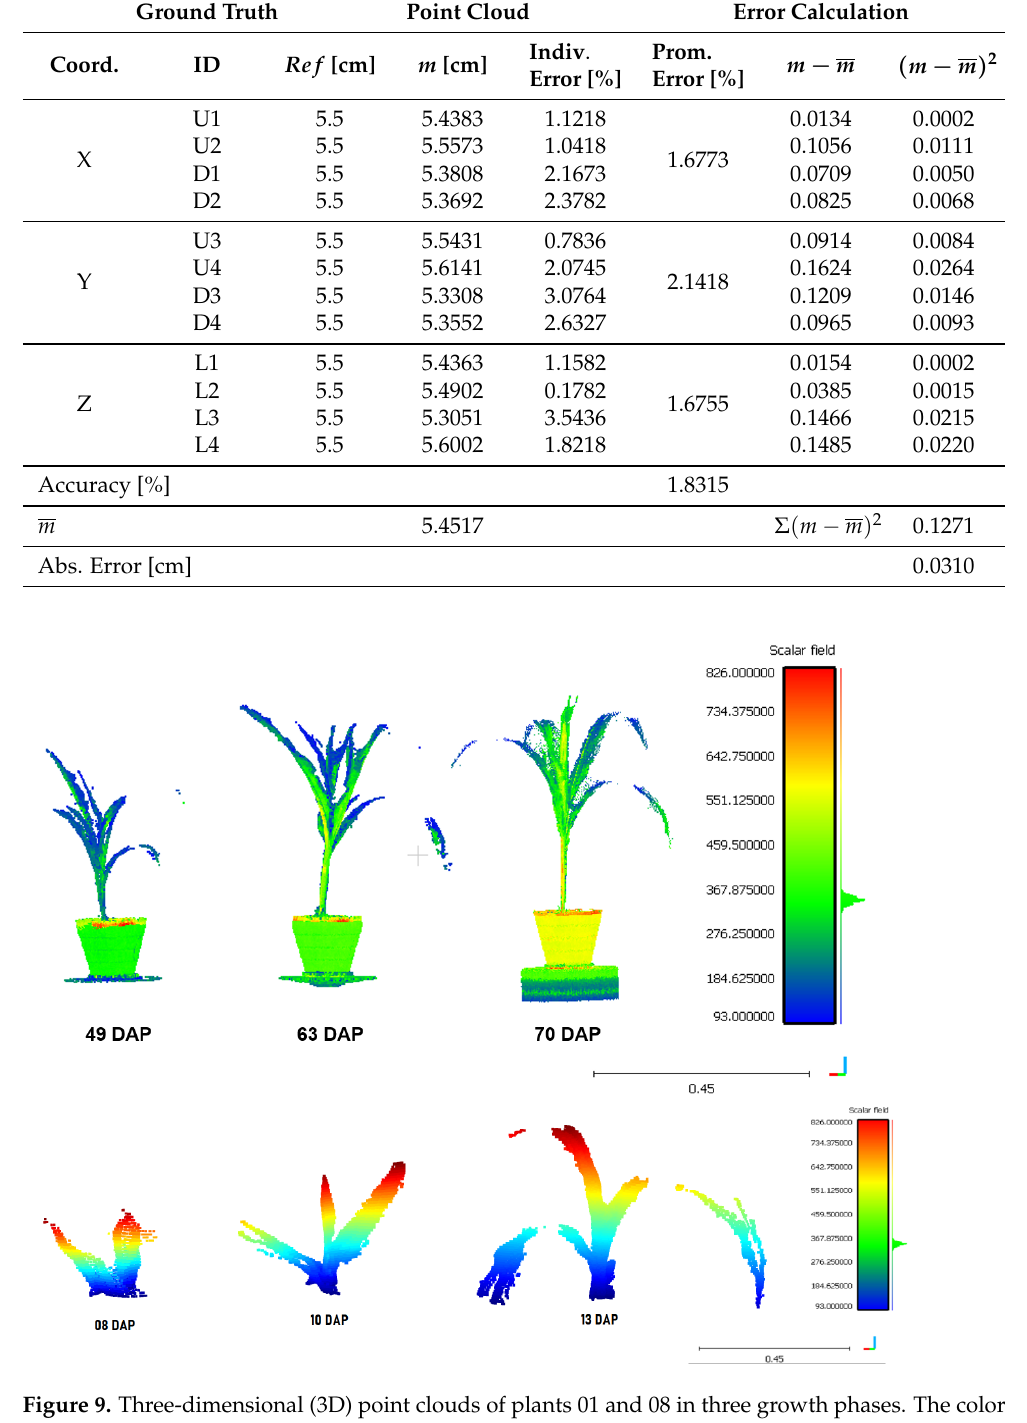
Figure 9. Three-dimensional (3D) point clouds of plants 01 and 08 in three growth phases. The color scale corresponds to the signal strength received by the